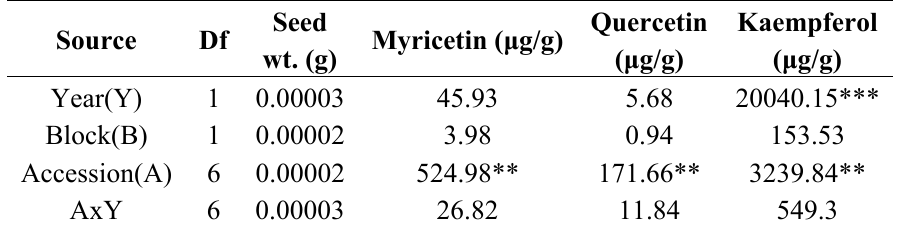
Table 3. Mean squares from analysis of variance of seed wt. (g) and flavonol concentration ( μ g/g DW) of horse gram seeds harvested from seven accessions (A) and grown in two years